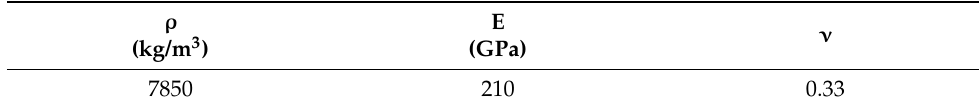
Table 4. MAT_RIGID material model of the Q235 steel [28].